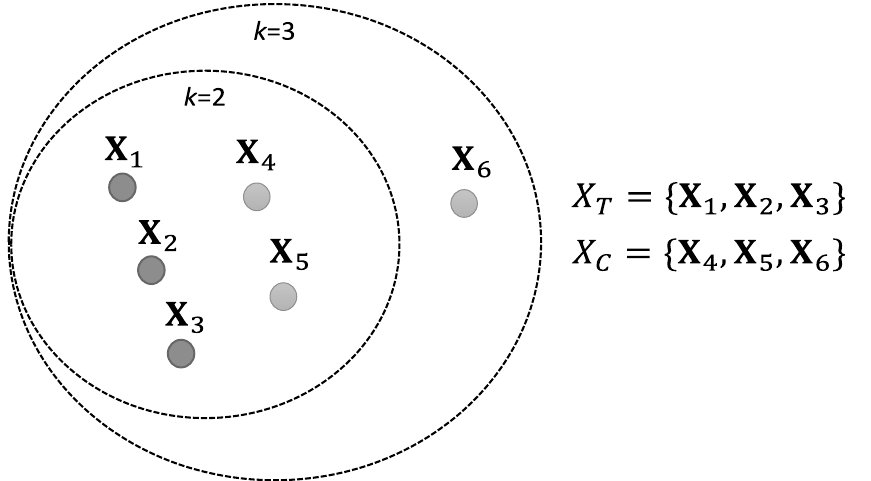
Figure 1. Demonstration of conflicting pairs in a reduced environment X 1 , X 2 and X 3 are three individuals from the treated group and X 4 , X 5 , and X 6 are three individuals from the candidate group. In the case of a k = 2 reduced environment, 1:1 matching cannot be performed; while in the case of a k = 3 reduced environment, conflicts can be